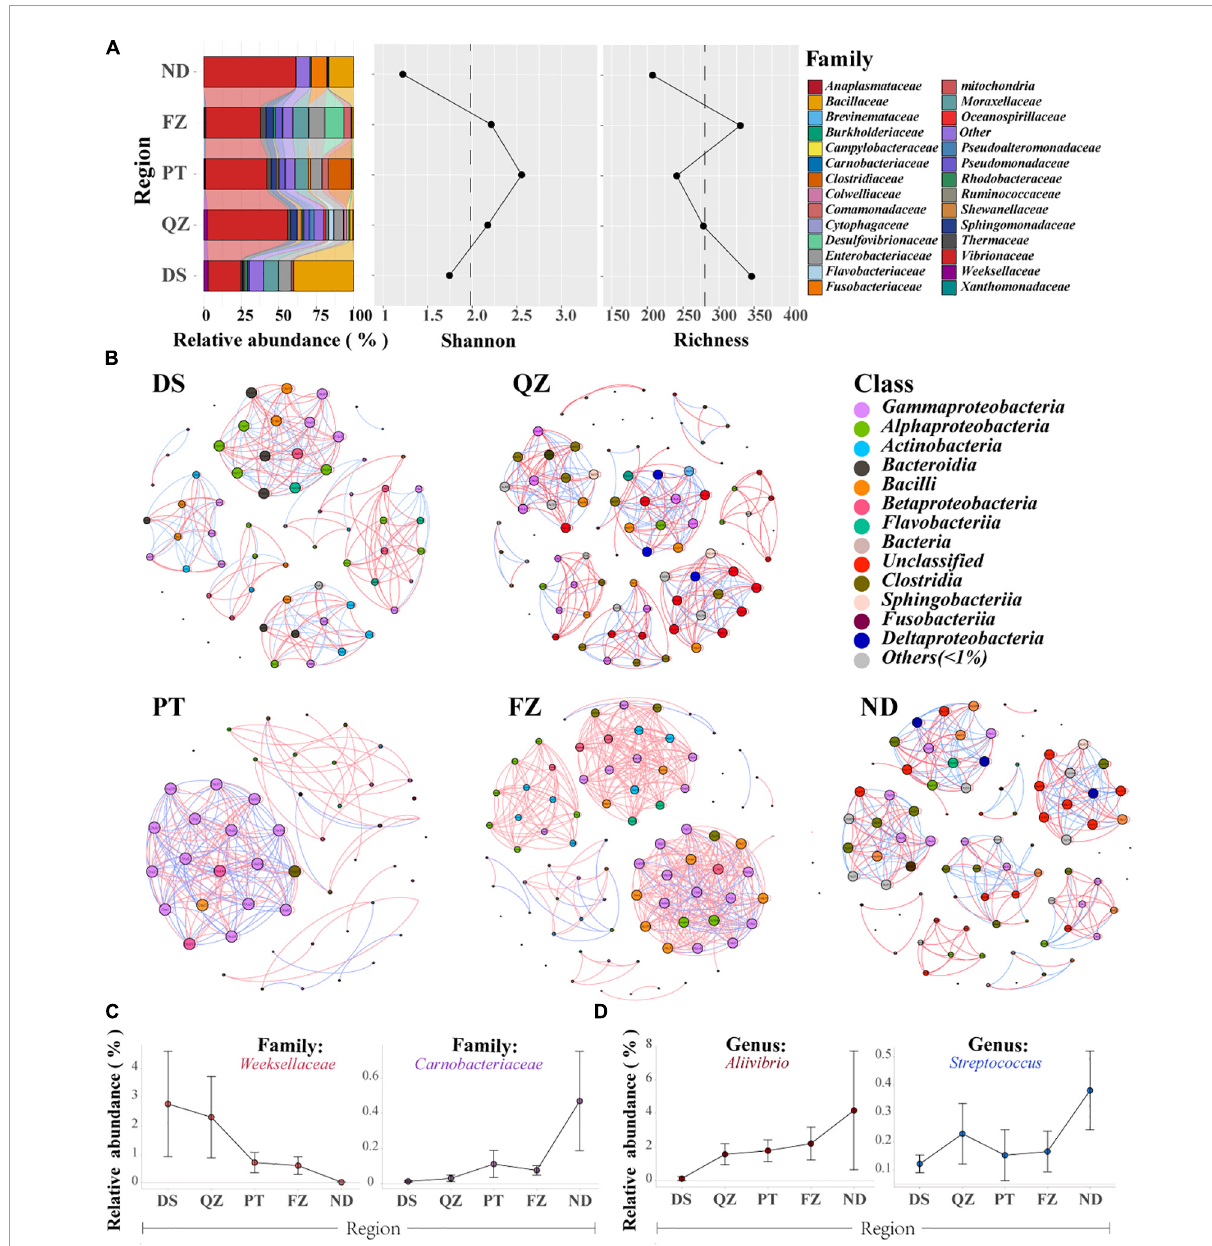
FIGURE2 Gut microbial communities of the same marine commercial fish ( E. akaara ) will also be affected by the factors of different habitats. (A) Divergence of microbial communities among the five habitat groups (DS, QZ, PT, FZ, and ND) of Ea, with the relative abundance, richness, and Shannon index analysis. Only the dominant microbial family with top 28 of each group are plotted. (B) Networks of co-occurring bacterial OTUs in Ea from the five habitat groups based on the correlation analysis. The co-occurring networks are colored by class. A red edge indicates a positive interaction between two individual nodes, while a blue edge indicates a negative interaction. (C) Relative abundance of the specificity patterns from south to north at the family level. (D) Relative abundance of the specificity patterns from south to north at the genus level.